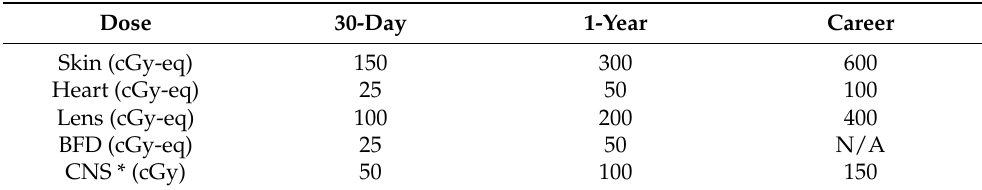
Table 1. NASA’s permissible organ dose limits for 30 days, 1 year, and the entire career for short-term or career non-cancer effects